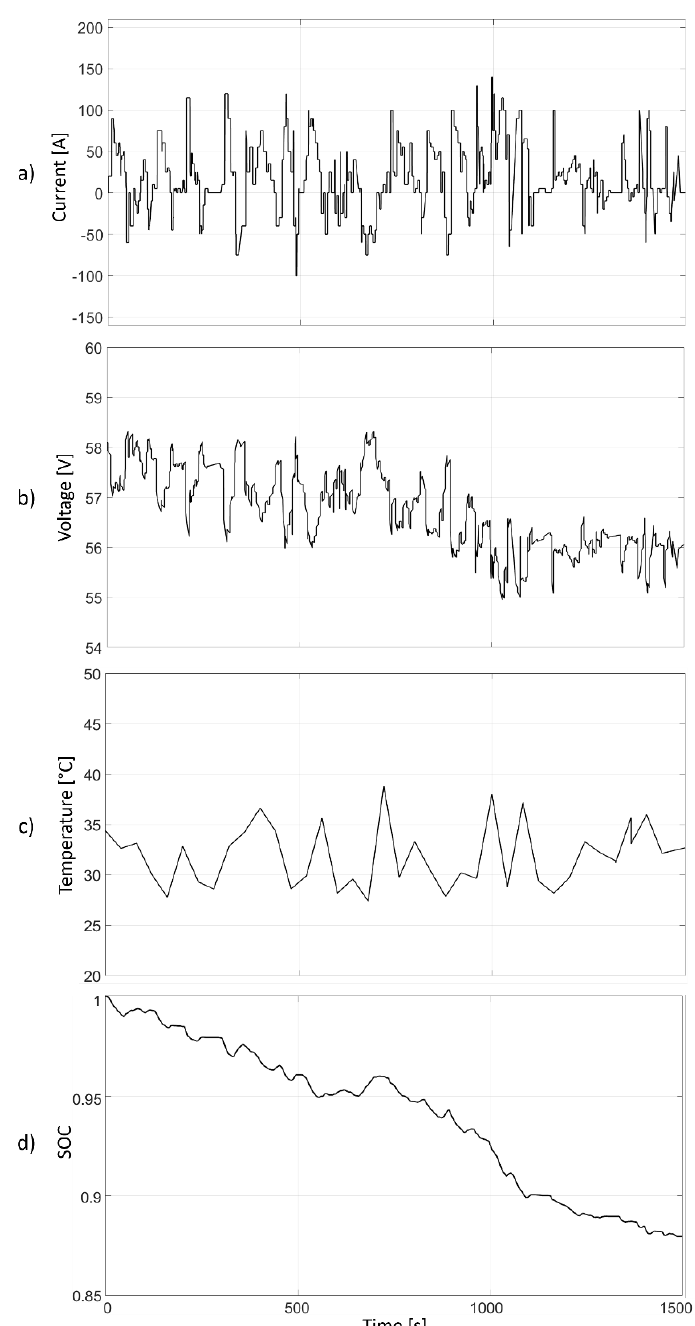
Figure 4. Training profiles. ( a ) Current charge / discharge. ( b ) Voltage. ( c ) Temperature. ( d ) State of Charge.